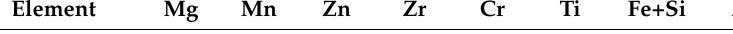
Table 1. Chemical composition of the studied alloy (wt. %).